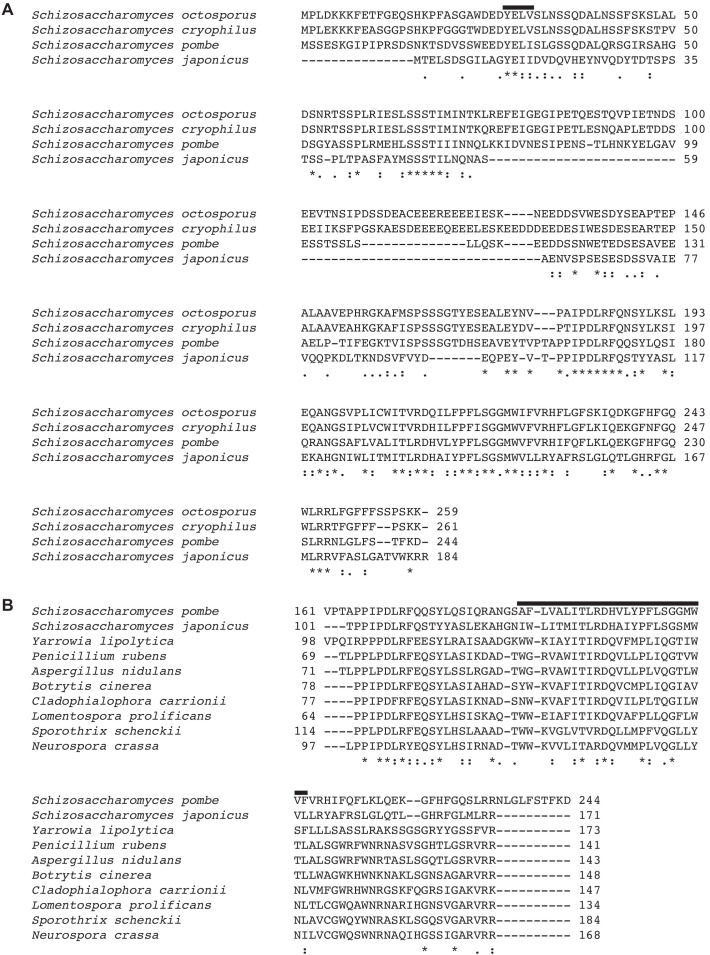
The C-terminal region of Atg43 is conserved.(A) A multiple sequence alignment of Atg43 proteins in the Schizosaccharomyces species. The alignment was produced using ClustalW and modified manually. The N-terminal AIM is indicated. (B) Alignment of fungal sequences similar to the C-terminal region of Atg43. The alignment was produced using ClustalW and modified manually. The predicted C-terminal transmembrane domain is indicated.